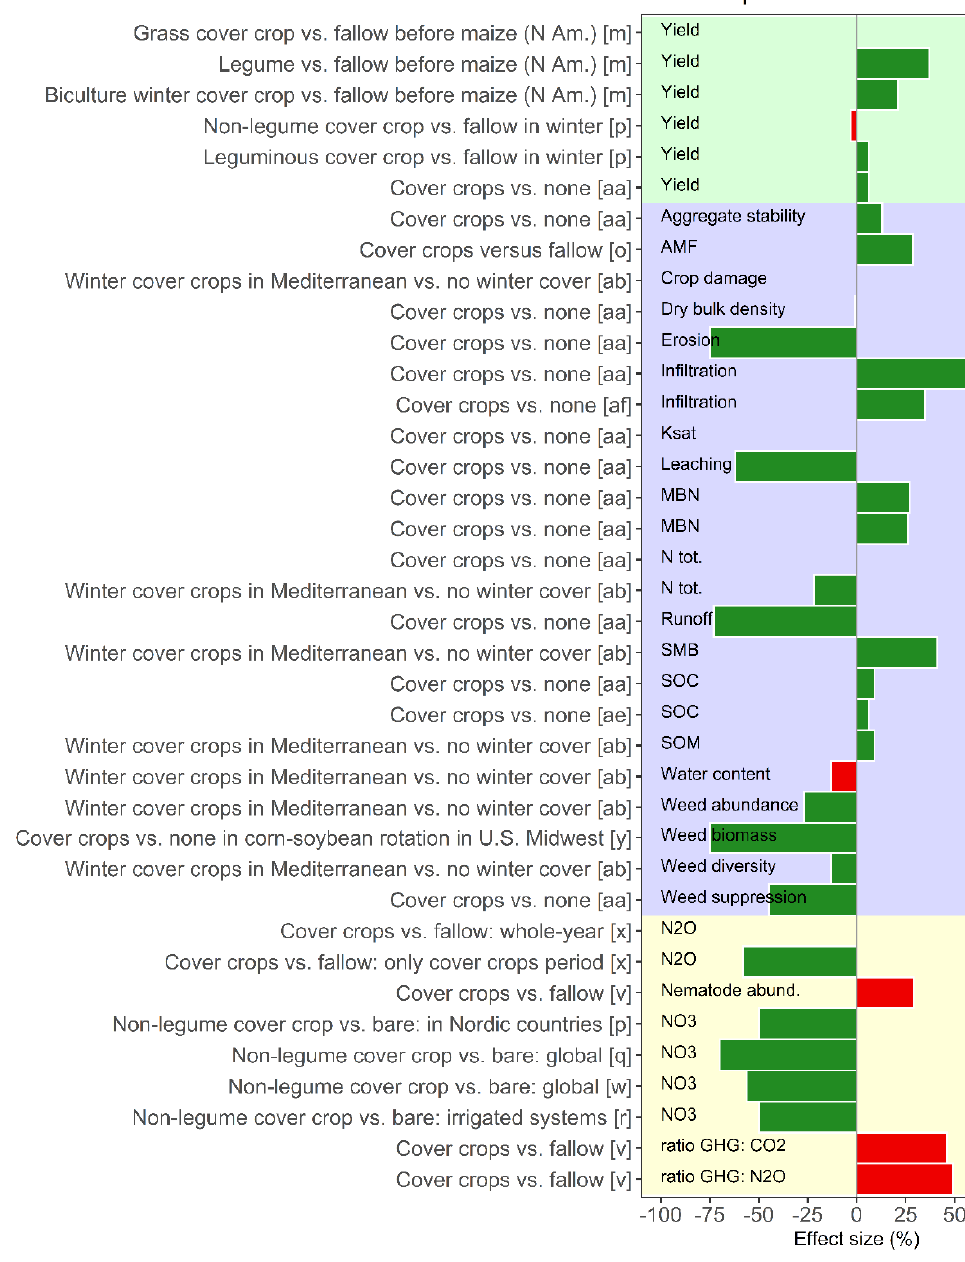
Figure 2. Overall effect sizes (response ratios) reported in meta-analysis studies on cropping (split in crop types and crop rotation, cover crops, intercropping, and perennial crops) grouped per area of interest (light green: agronomic; light blue: soil quality; light orange: resource use efficiency; light brown: economic (no data); light yellow: environmental impacts). The management or treatment comparison is indicated outside the y-axis and the variable to which the data refer are listed inside the y-axis (abbreviations can be found in Table A1). Green bars indicate improvement, red bars indicate worsening. See also Table S1. [a]: [24] ; [b]: [28] ; [c]: [27] ; [d]: [40] ; [e]: [41] ; [f]: [42] ; [g]: [38] ; [h]: [43] ; [i]: [44] ; [j]: [30] ; [k]: [45] ; [l]: [46] ; [m]: [47] ; [n]: [48] ; [o]: [49] ; [p]: [32] ; [q]: [31] ; [r]: [50] ; [s]: [51] ; [t]: [52] ; [u]: [33] ; [v]: [53] ; [w]: [54] ; [x]: [39] ; [y]: [55] ; [z]: [56] ; [aa]: [57] ; [ab]: [58] ; [ac]: [59] ; [ad]: [60] ; [ae]: [61] ; [af]: [62] .